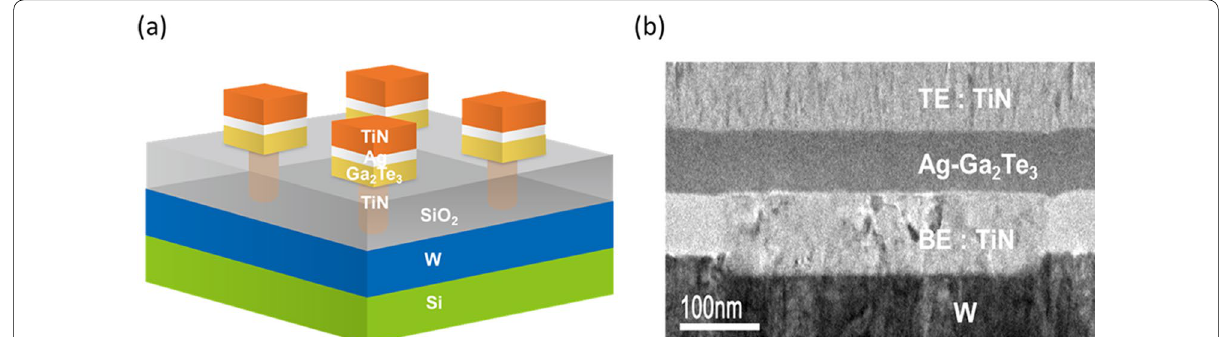
Fig. 1 a Schematic of the Ag/Ga 2 Te 3 selector devices. b Cross-sectional TEM image of the TiN/Ag-Ga 2 Te 3 /TiN selector